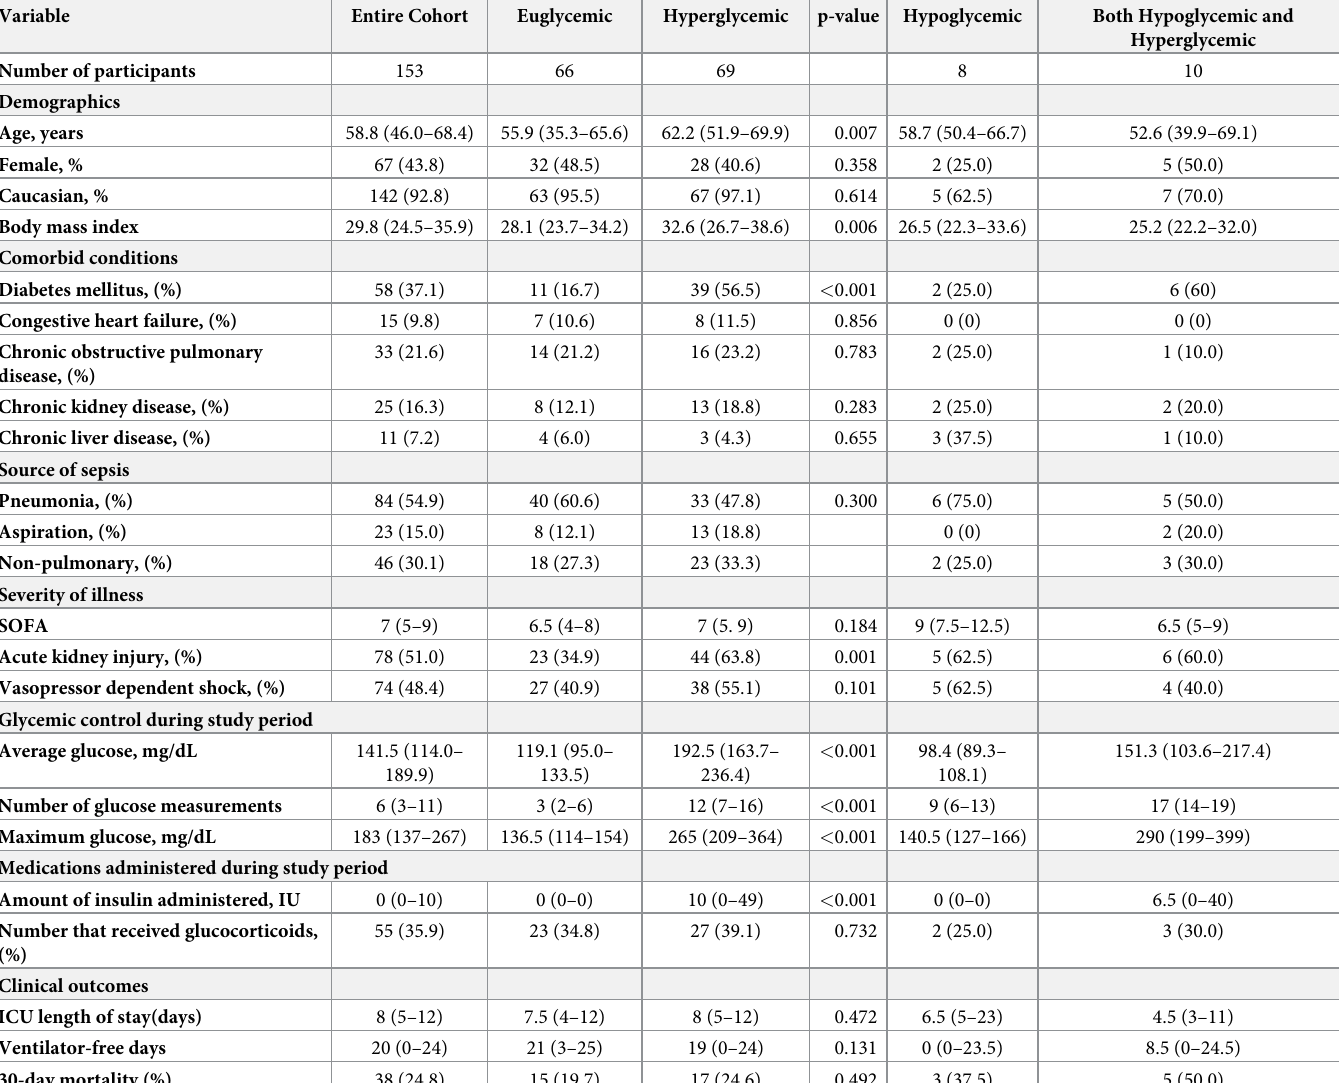
Table 1. Participant